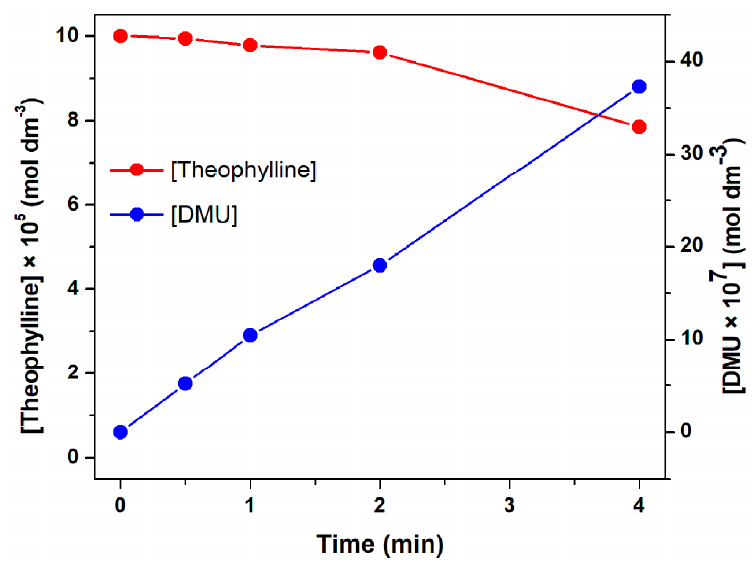
Figure 6. Variation in the concentration of Theophylline (red) and 1, 3-dimethyluric acid (DMU; blue) as a function of time.